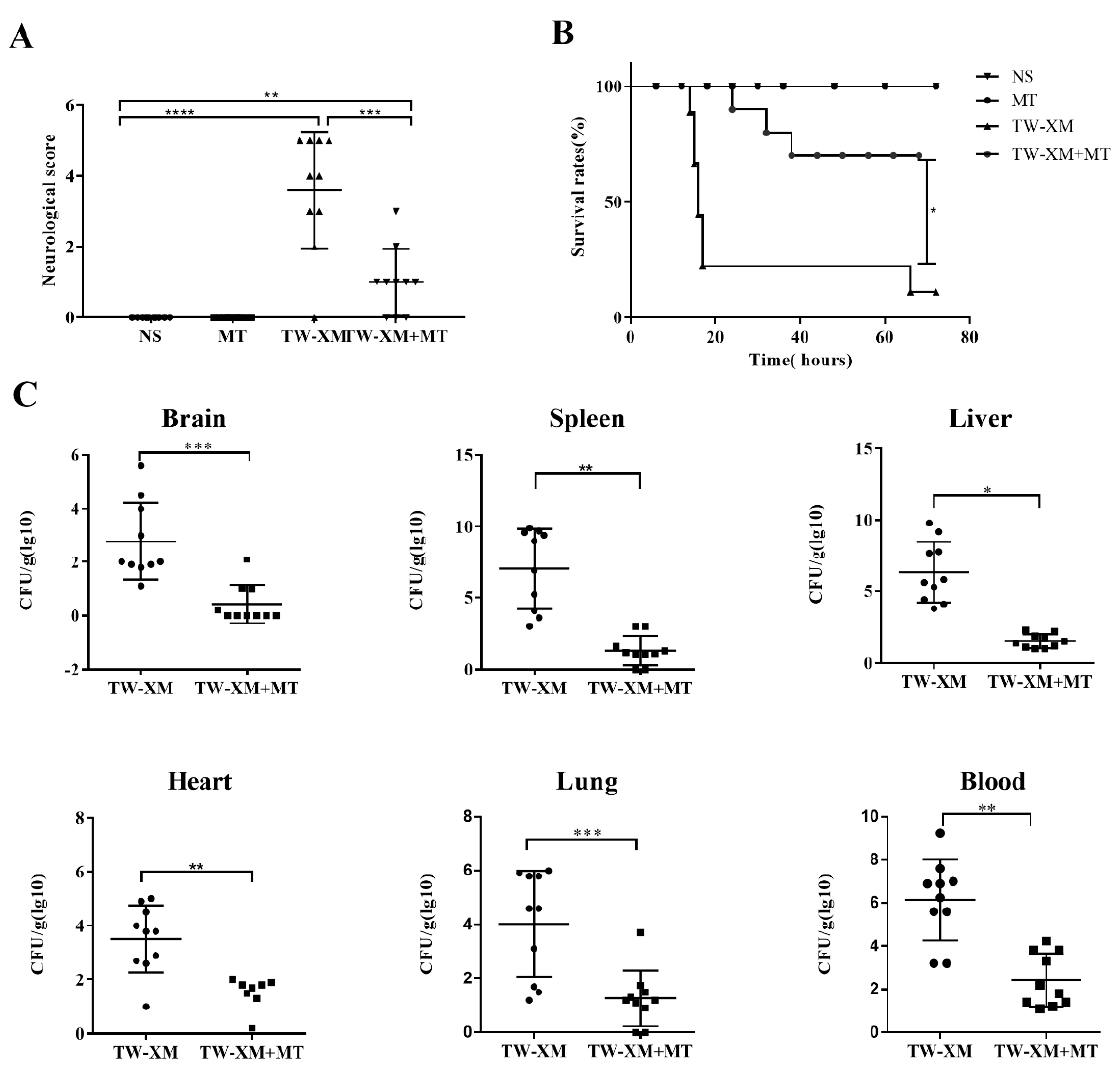
Figure 1. The effect of melatonin on neurological symptoms, survival rates, and bacterial counts of tissues and blood in TW − XM − infected ICR mice. ( A ) The neurological symptom scores of ICR mice in different groups were analyzed at 12 h post infection. ( B ) The survival rates of ICR mice in different groups were analyzed. ( C ) The loads of TW − XM in brain, spleen, liver, heart, lungs, and blood were analyzed in the TW − XM group and the TW-XM+MT group at 12 h post infection. Each point represents one mouse. All data were determined by one-way ANOVA and expressed as means ± SEM. * p < 0.05, ** p < 0.01, *** p < 0.001, **** p < 0.0001,